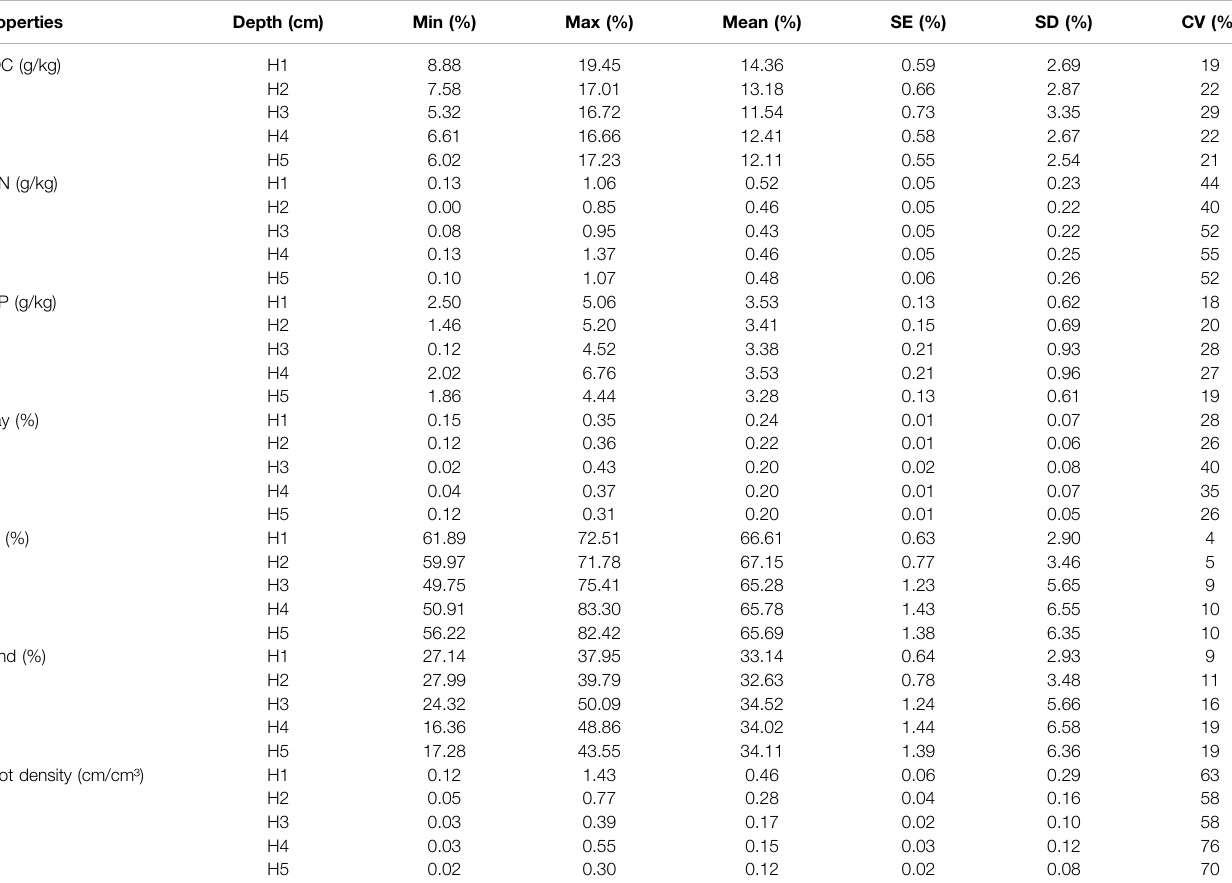
TABLE 1 | Statistical characteristics of soil properties at different